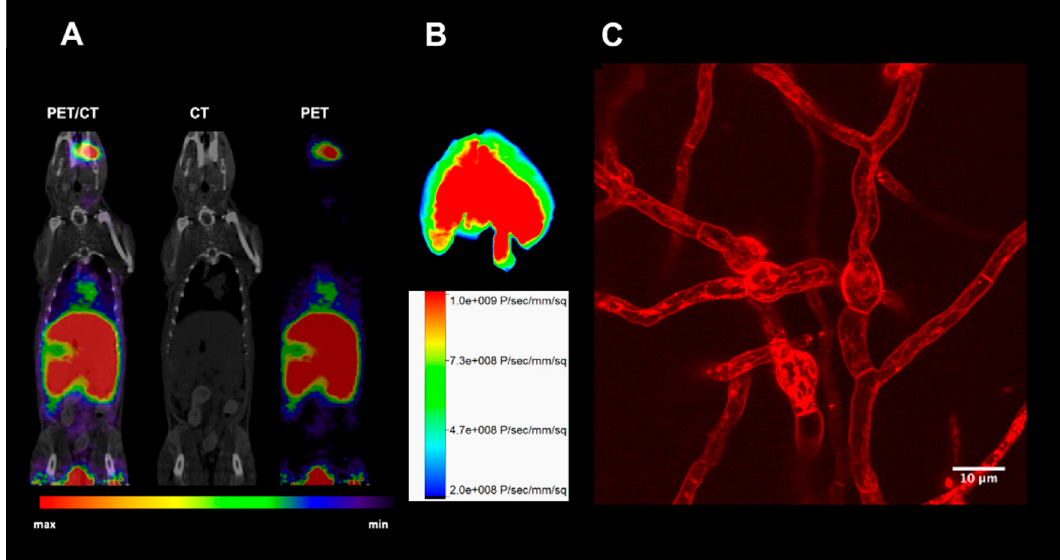
Figure 3. µPET/CT image of [ 68 Ga]Ga-DAFC-Cy5 of an immunocompromised Lewis rat infected with A. fumigatus. ( A ) Signal in the lung region reflects uptake of radiolabeled siderophore. ( B ) Optical image of the dissected lung; a fluorescence signal can be clearly seen uniformly distributed. ( C ) Fluorescence microscopy image of [Fe]DAFC-Cy5 in A. fumigatus hyphae.